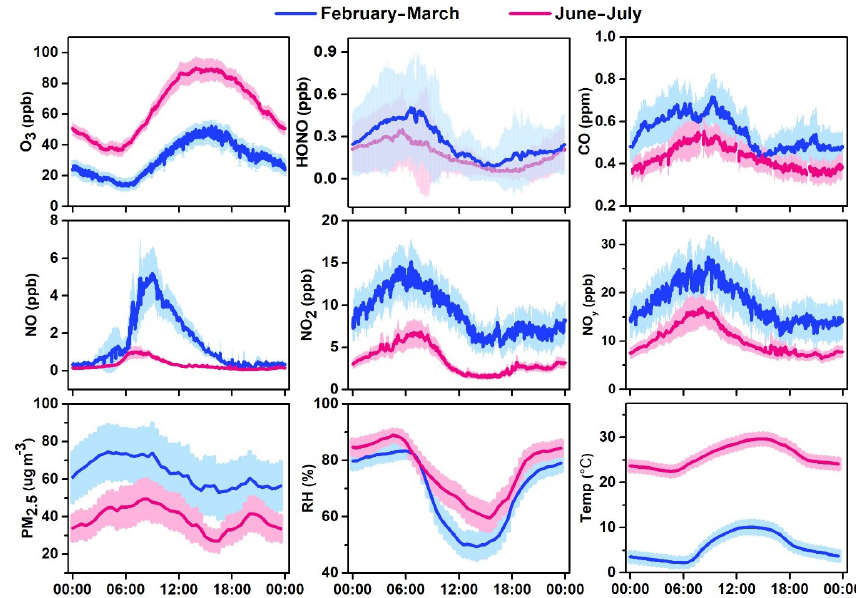
Figure 3. Average diurnal patterns of major trace gases, PM 2 . 5 , and meteorological parameters at the study site during February–March and June–July 2017. Error bars indicate the half standard deviation of the mean (blue line: February–March; red line: